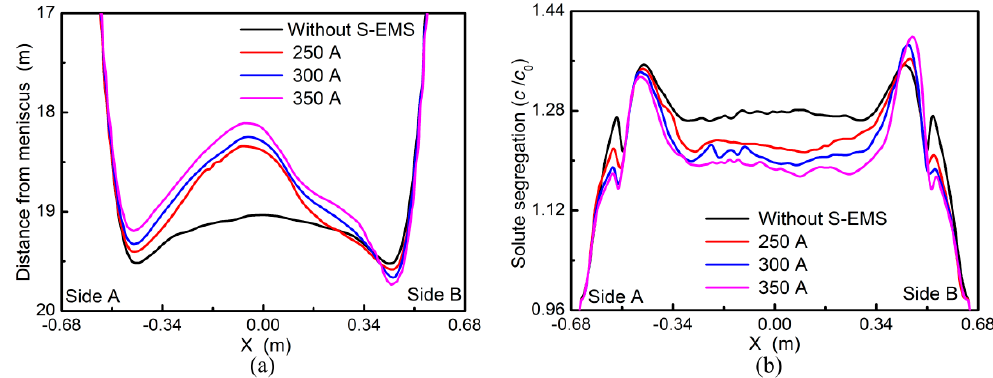
Figure 11. Solidification end profile ( a ) and centerline segregation ( b ) along the transverse direction.